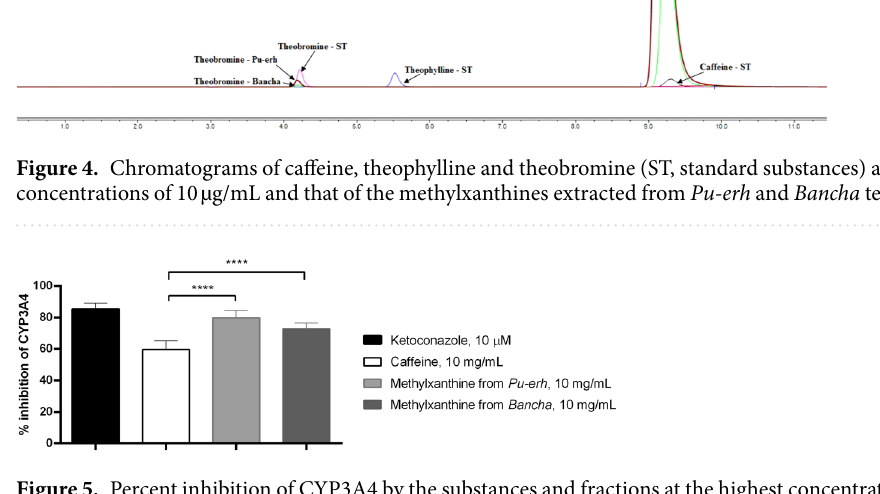
Figure 5. Percent inhibition of CYP3A4 by the substances and fractions at the highest concentrations evaluated in this study. Columns show mean values ± S.D. of n = 6 independent experiments. ANOVA was performed to determine the significance of the differences between groups. **** p <